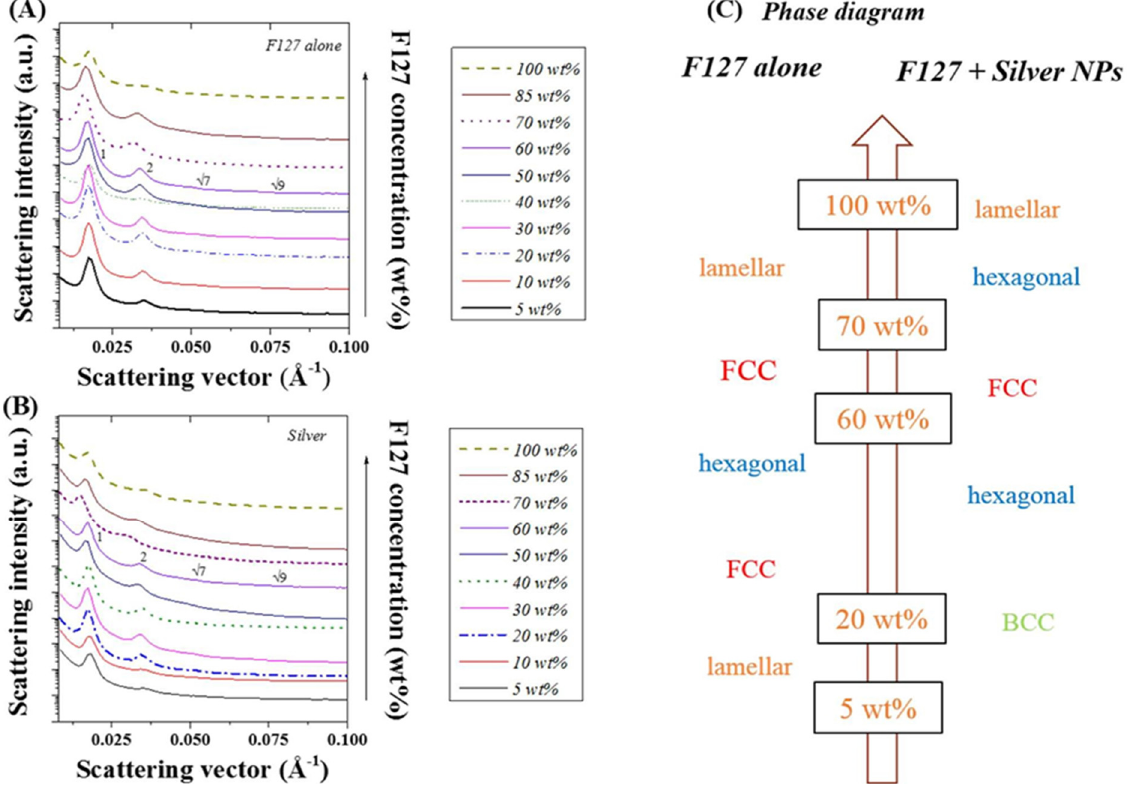
Figure 2. Small angle x ray scattering (SAXS) spectra obtained for ( A ) F127 in water at different LLC/water ratios; ( B ) after addition of 20 nm diameter silver NPs (15 wt %); and ( C ) corresponding ordered phases obtained from peak ratio identification (Table